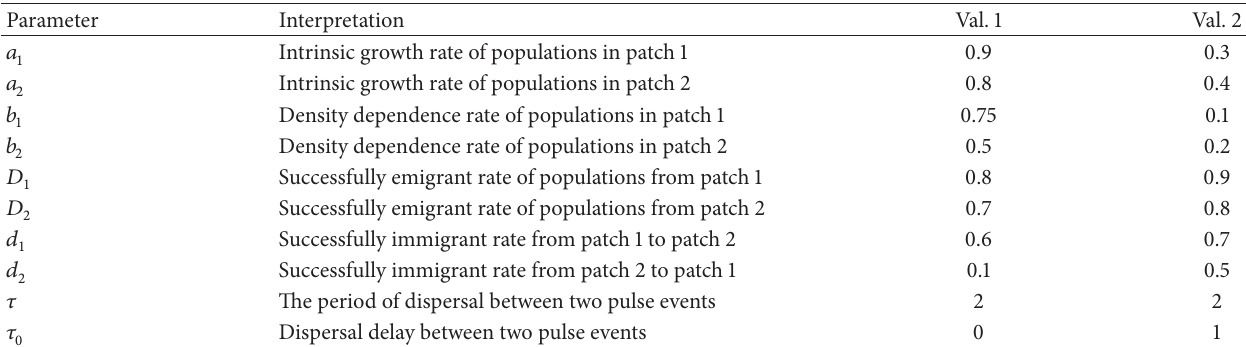
Table 1: Parameter values used in the simulations of Model (4).